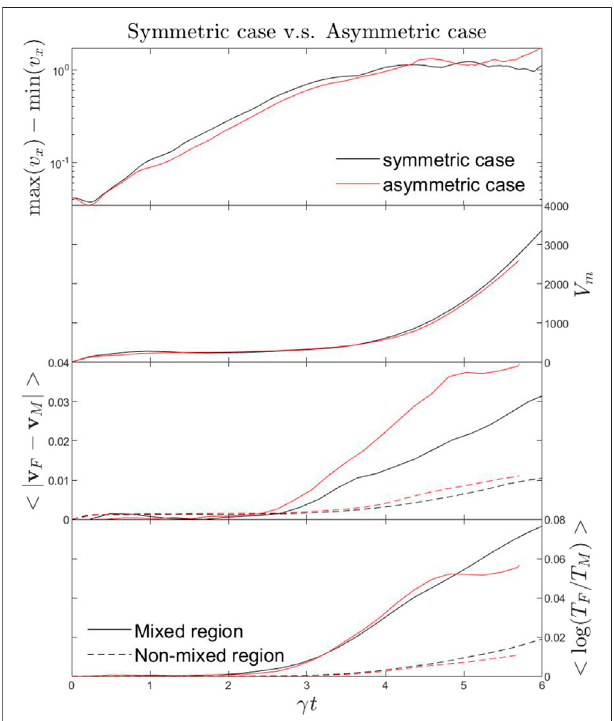
FIGURE 6 | The overall dynamical properties for the symmetric case (black lines) and the asymmetric case (red lines) in a normalized time scale (i.e., c t ). The top to bottom panels show the growth of the KH instability (the range of the bulk velocity v x component), the total mixed volume, V m (based on H+), the change of < | v F − v M | > , and change of < |log( T F / T M )| > for mixed region (solid lines) and non-mixed region (dashed